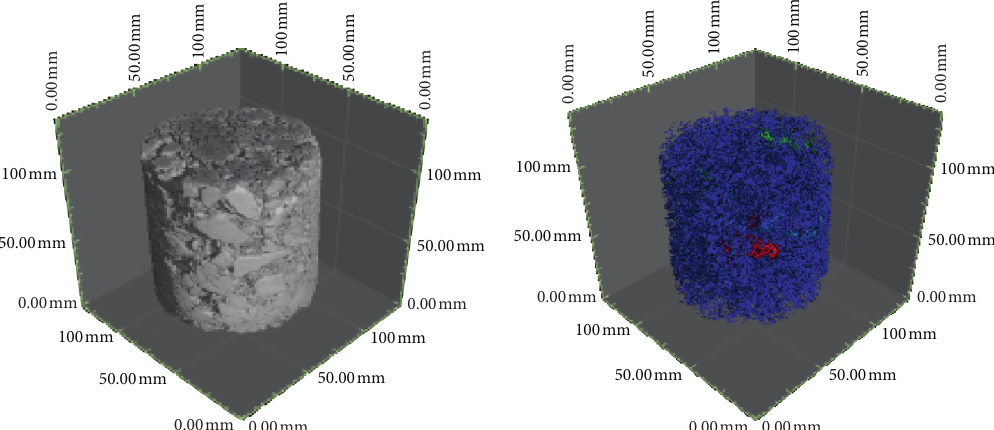
Figure 4: Three-dimensional void of CSM.